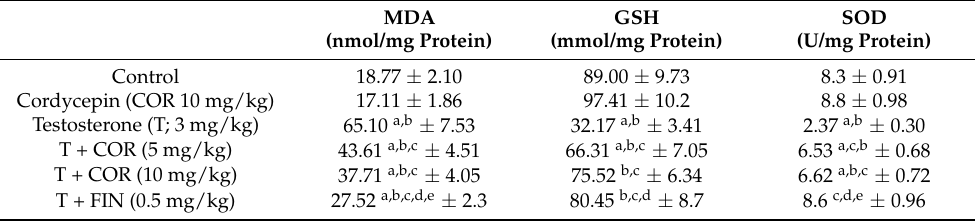
Table 2. Effect of cordycepin on oxidative status in prostatic tissues of testosterone-treated